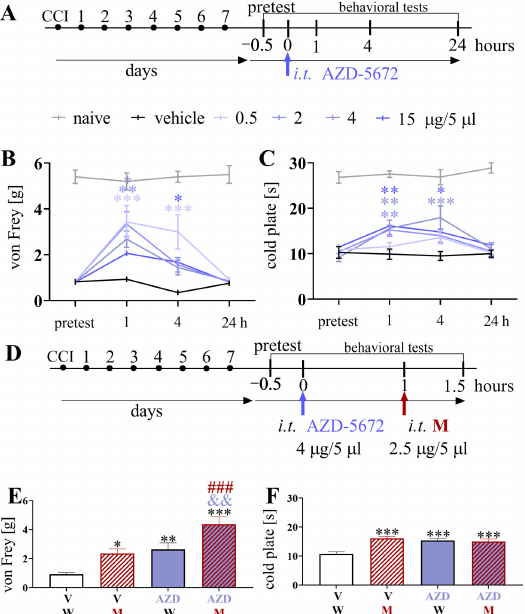
Figure 8 Figure 8. The effects of CCR5 antagonists (AZD-5672) administered intrathecally (i.t.) according to timeline ( A ), at doses of 0.5, 2, 4, and 15 µ g/5 µ L on mechanical ( B ) and thermal ( C ) hypersensitivity and the influence of AZD-5672 at a dose of 4 µ g/5 µ L plus morphine 2.5 µ g/5 µ L on mechanical ( E ) and thermal ( F ) hypersensitivity, administered according to timeline ( D ), 7 days after CCI in mice. The data are presented as the mean ± SEM (naive n = 5; CCI n = 8–10). The results